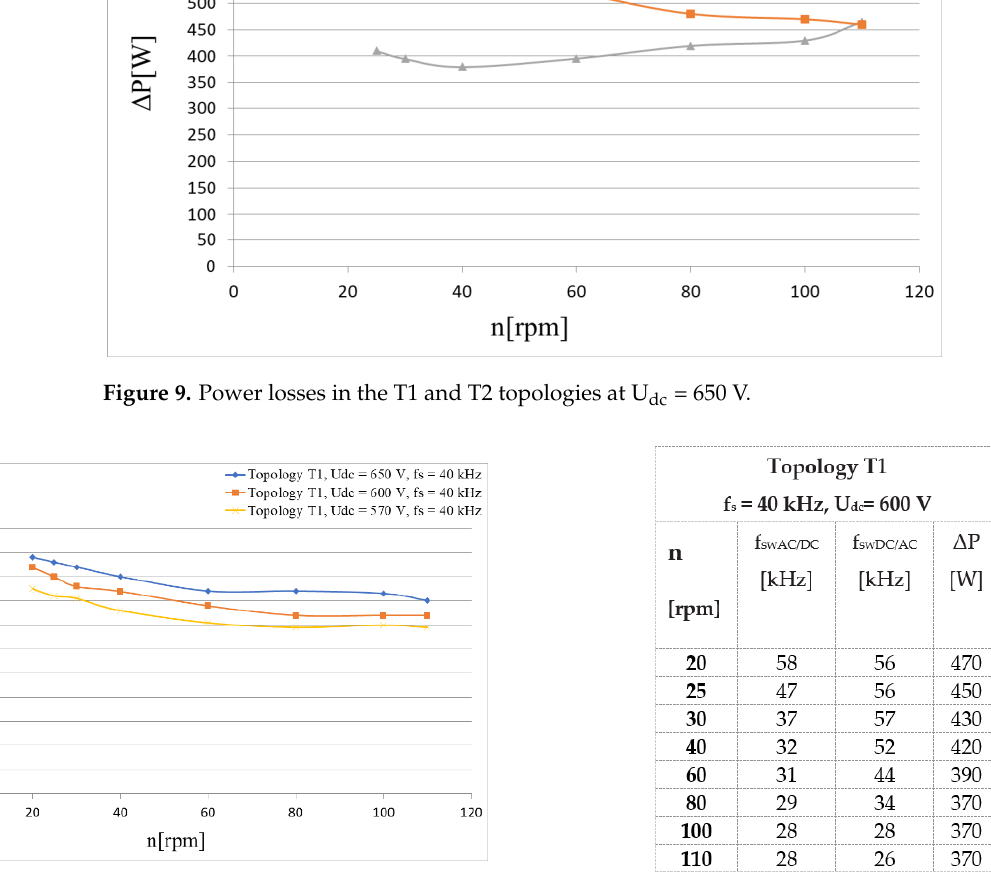
tice that voltage changes in the DC link have a similar effect on power losses as in the topology T1 but to a lesser extent and that they are caused by an increase in switching losses only in the grid converter. Naturally, as with the topology T1, it is necessary to strive for a possibly lowest U dc voltage ensuring the correct operation of the grid con- verter. 4.4. Effect of Switching Frequency on the Generator Converter Efficiency Power losses in the topology T1 depending on the sampling frequency were rec- orded for two sampling frequencies of the generator converter: 20 kHz and 40 kHz (Fig- ure 12). The applied type  current control method ensures that the change in the sam- pling frequency does not result in a proportional change in the switching frequency of the generator converter transistors. At a sampling frequency f s = 20 kHz, the switching